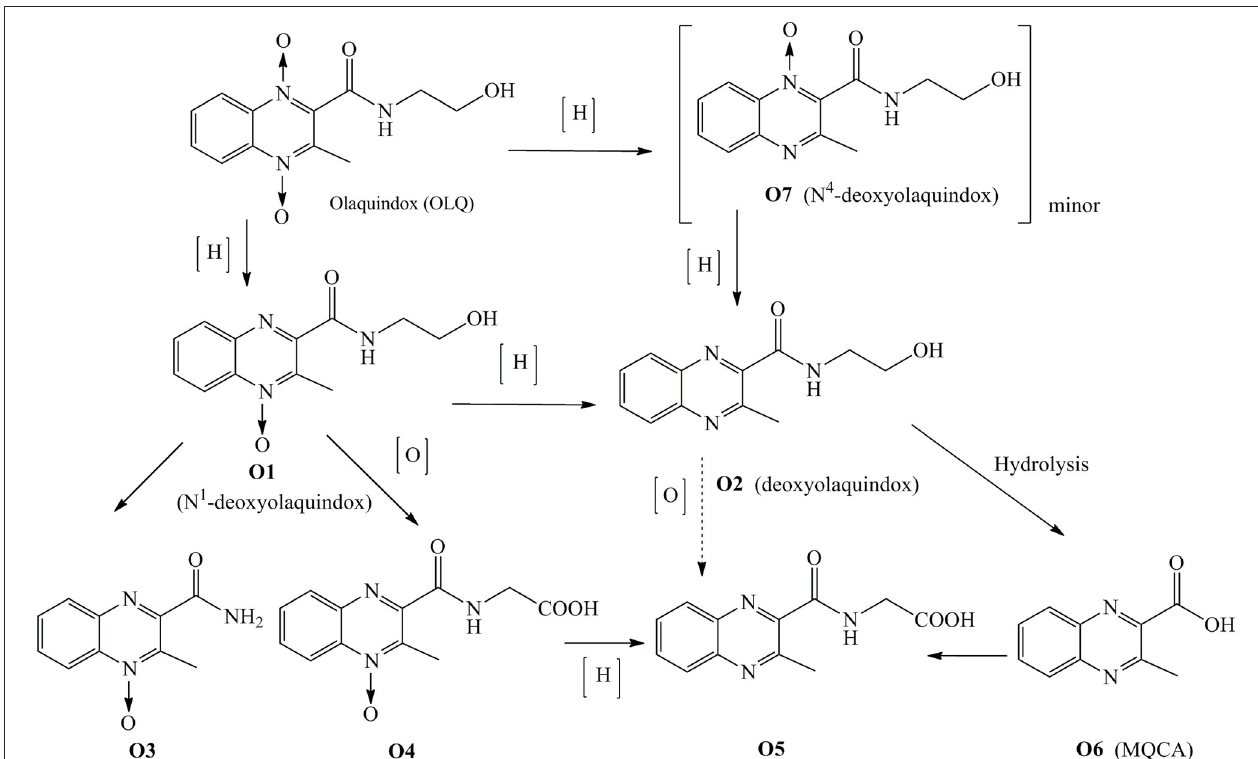
FIGURE 1 | The proposed metabolism pathway of olaquindox in pigs and broilers.